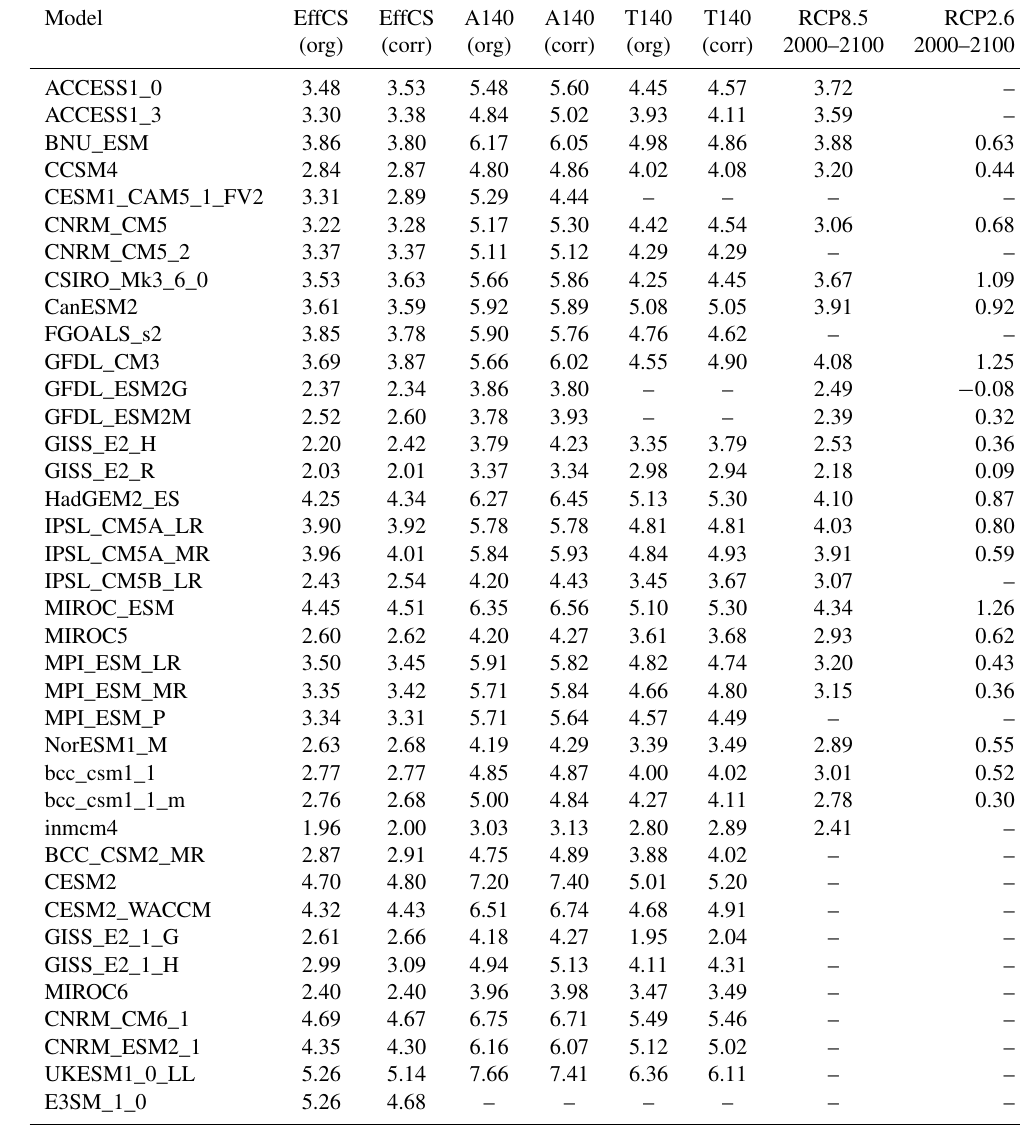
Table 3. A table showing various sensitivity metrics estimated from the CMIP5 and CMIP6 ensembles (in K), using both pre-industrial average baseline temperatures (org) and baseline temperatures estimated from a regression fit to the first 20 years of the 1cptCO2 simulation (corr), where the linear fit is used to estimate temperatures and radiative fluxes at t = 0. Warming is shown (where available) for corre- sponding RCP2.6 and RCP8.5 simulations, where the difference between 2001–2020 and 2081–2100 in the first ensemble member for the corresponding model is used to assess 21st century